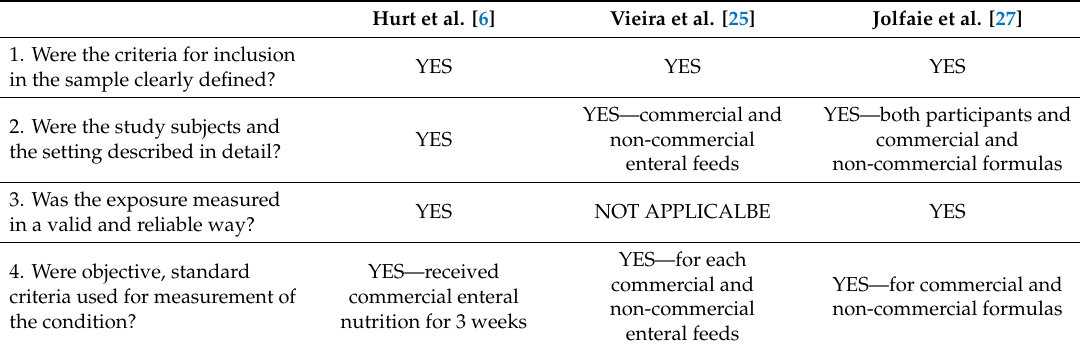
Table A2. Joanna Briggs Institute Critical Analysis Tool for Cross-sectional